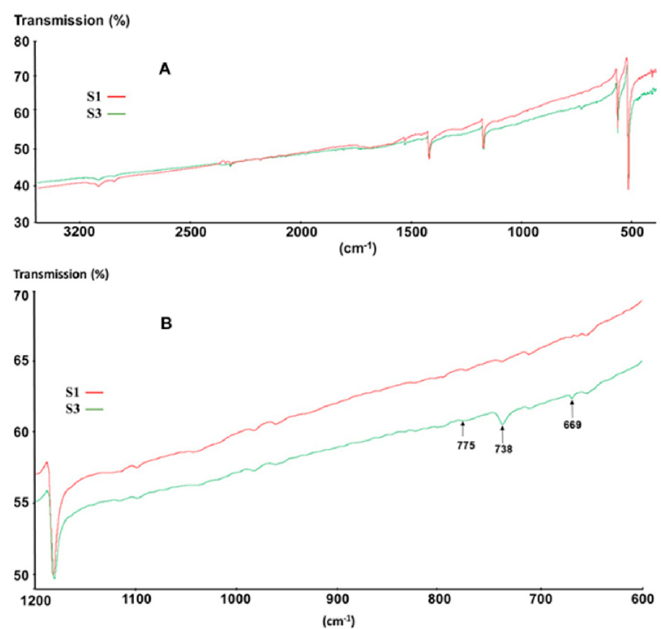
Figure 5. ( A ) FTIR (Fourier-transform infrared spectroscopy) spectra of S1 (red) and S3 (green); ( B ) magnification of (A).